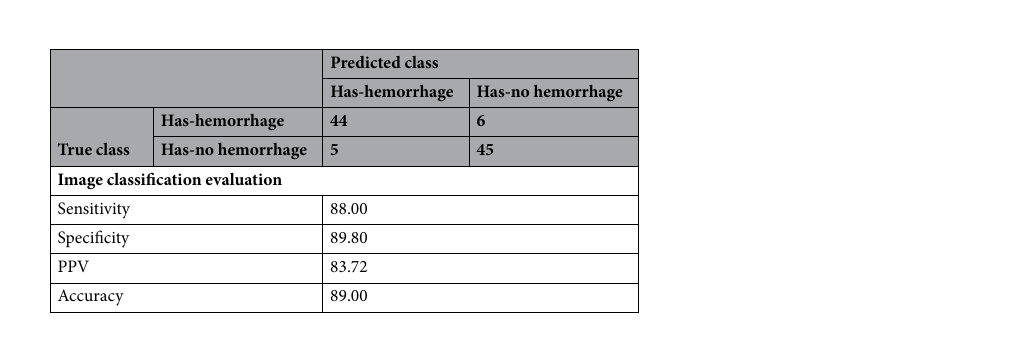
Table 3. Hemorrhage segmentation performance comparisons of KMMRC-INRG against comparative methods in the percentage of eight images with large hemorrhages. The highest values are bold.